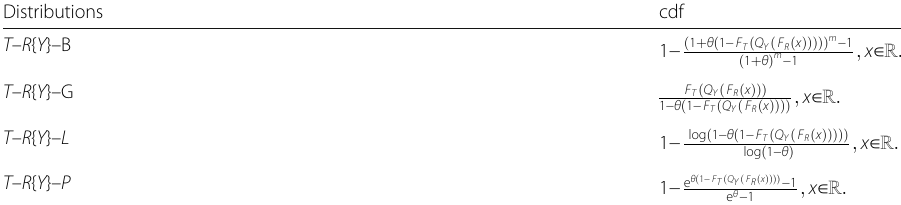
Table 2 Some sub-families of the T – R { Y } – PS family of distributions